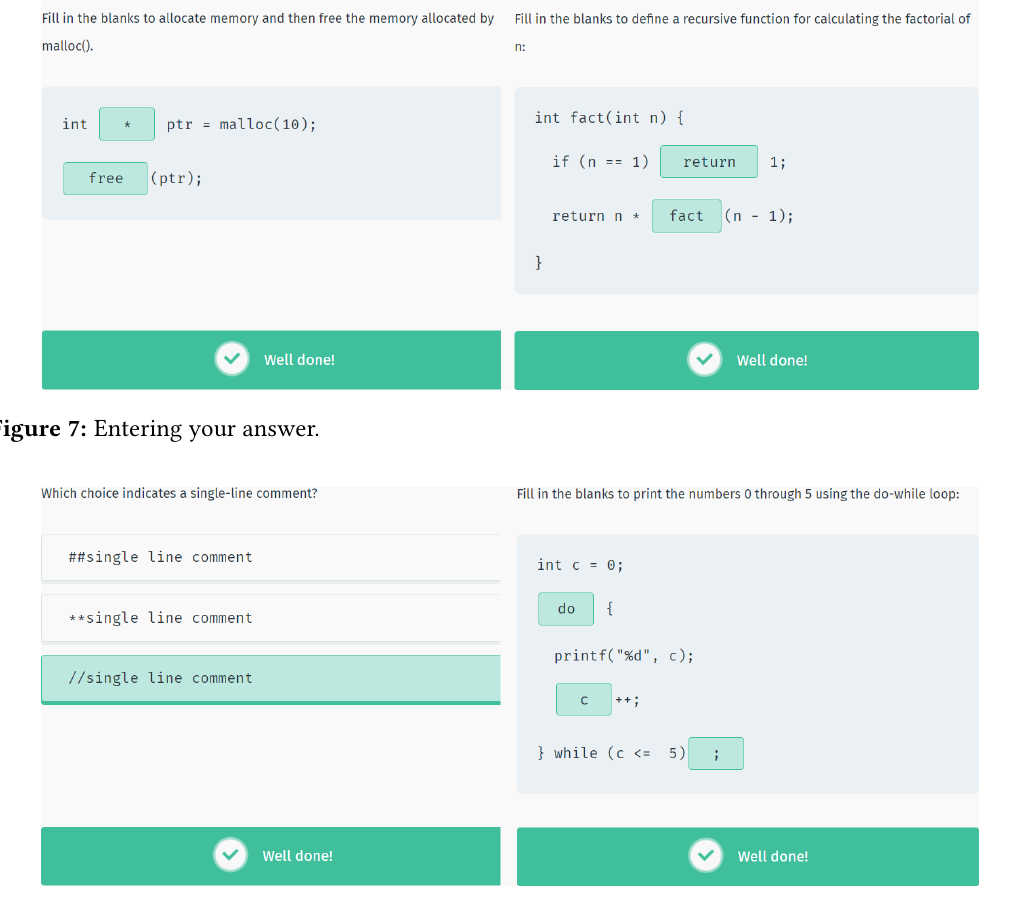
Figure 8: Module